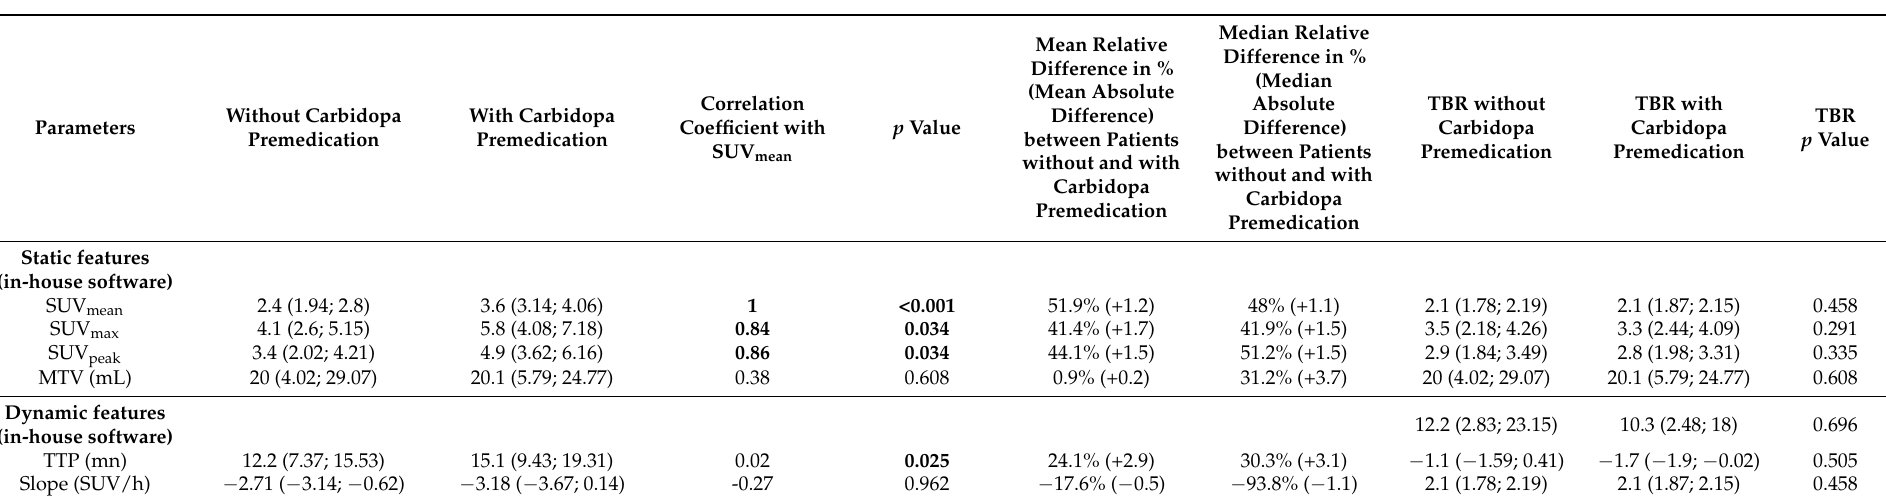
Table 3. Brain tumor extracted parameters in patients without and with carbidopa premedication and after normalization for healthy brain parameters with Tumor-to-normal-Brain Ratios